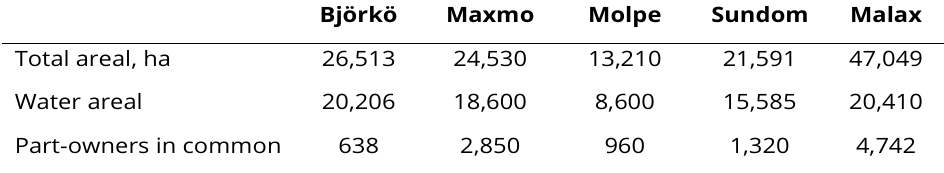
Table 1 . Areal and number of part-owners in the studied